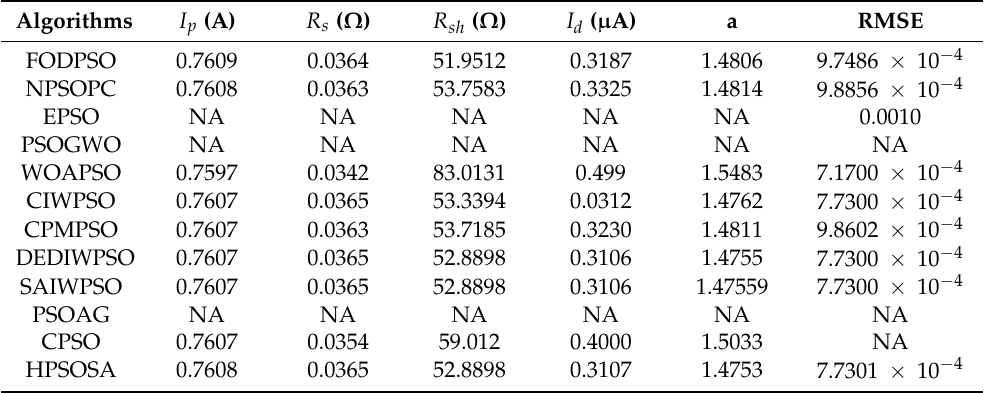
Table 4. Comparison of hybrid PSO algorithms for parameter estimation of RTC France solar cell (single-diode model).